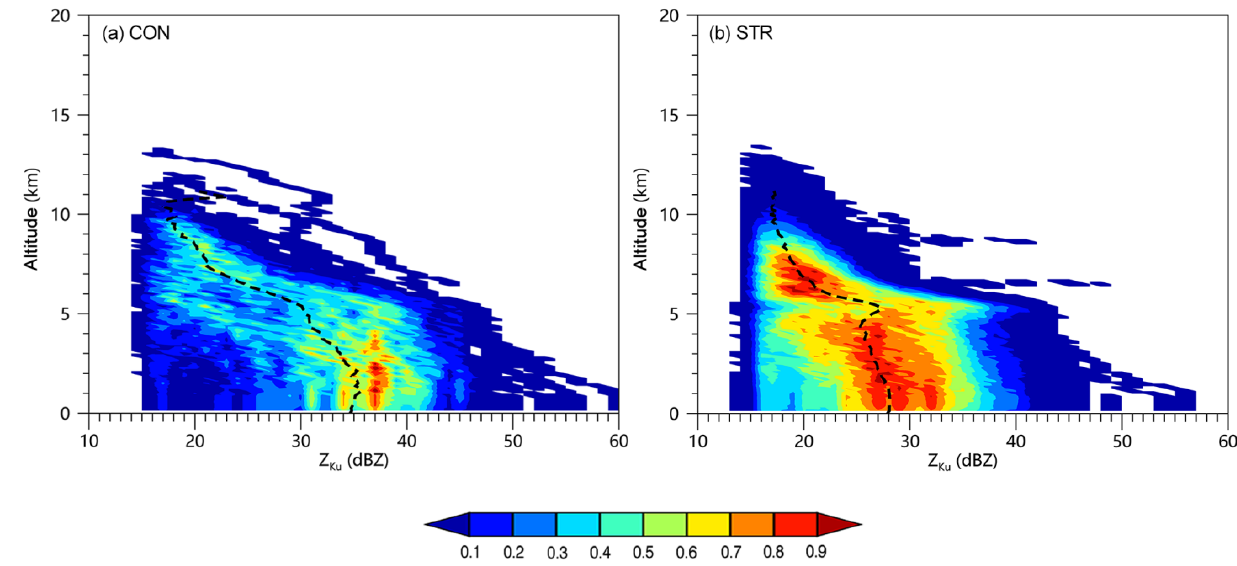
Figure 10. The CFADs of Ku-band equivalent radar reflectivity (Z Ku ) from GPM observation during Typhoon In-Fa landfall for two indicated rain types: ( a ) convective rain, ( b ) stratiform rain. The black dashed lines represent median lines. The time and location of GPM observation are shown in Figure 2.